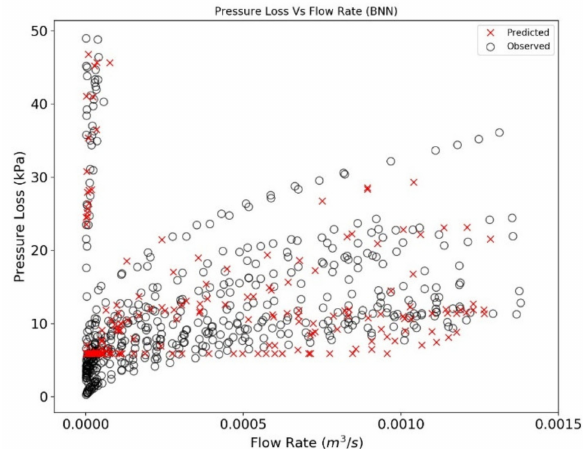
Figure 15. Observed and predicted pressure loss is plotted with flow rate for BNN algorithm for high pressure regime.